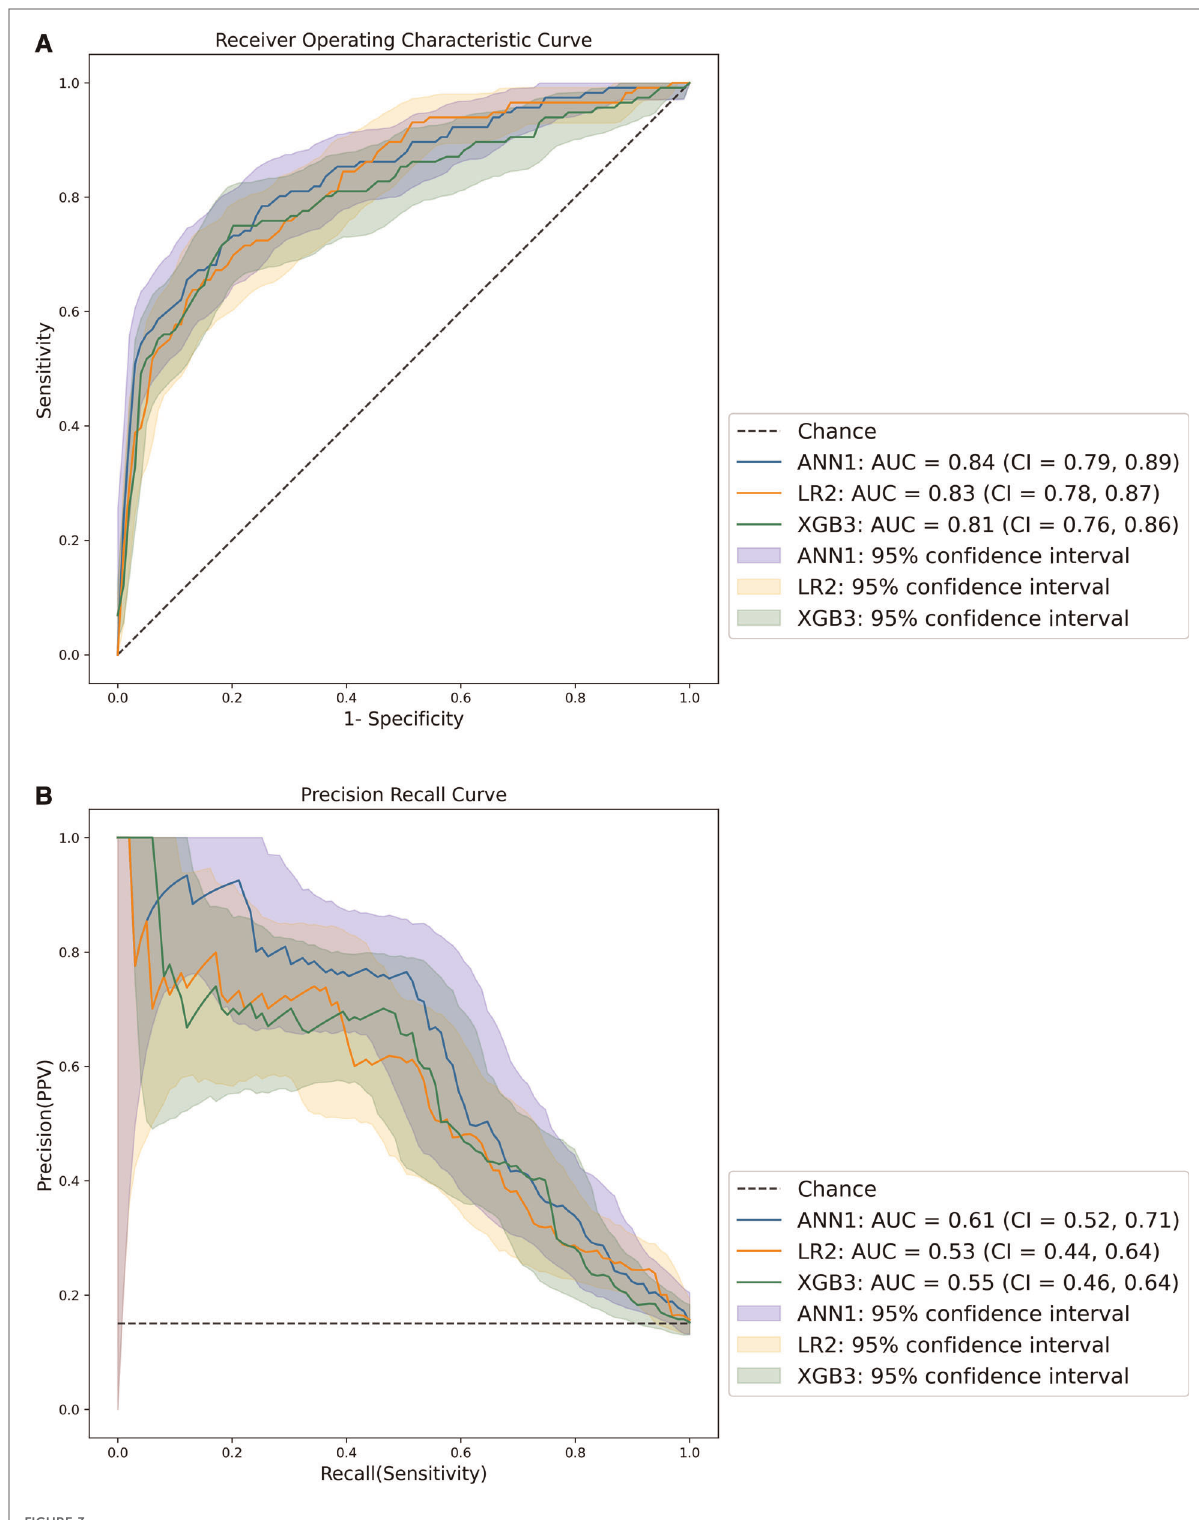
FIGURE 3 ROC ( A ) and PR ( B ) curves – AUC=area under the curve, CI=95% con fi dence